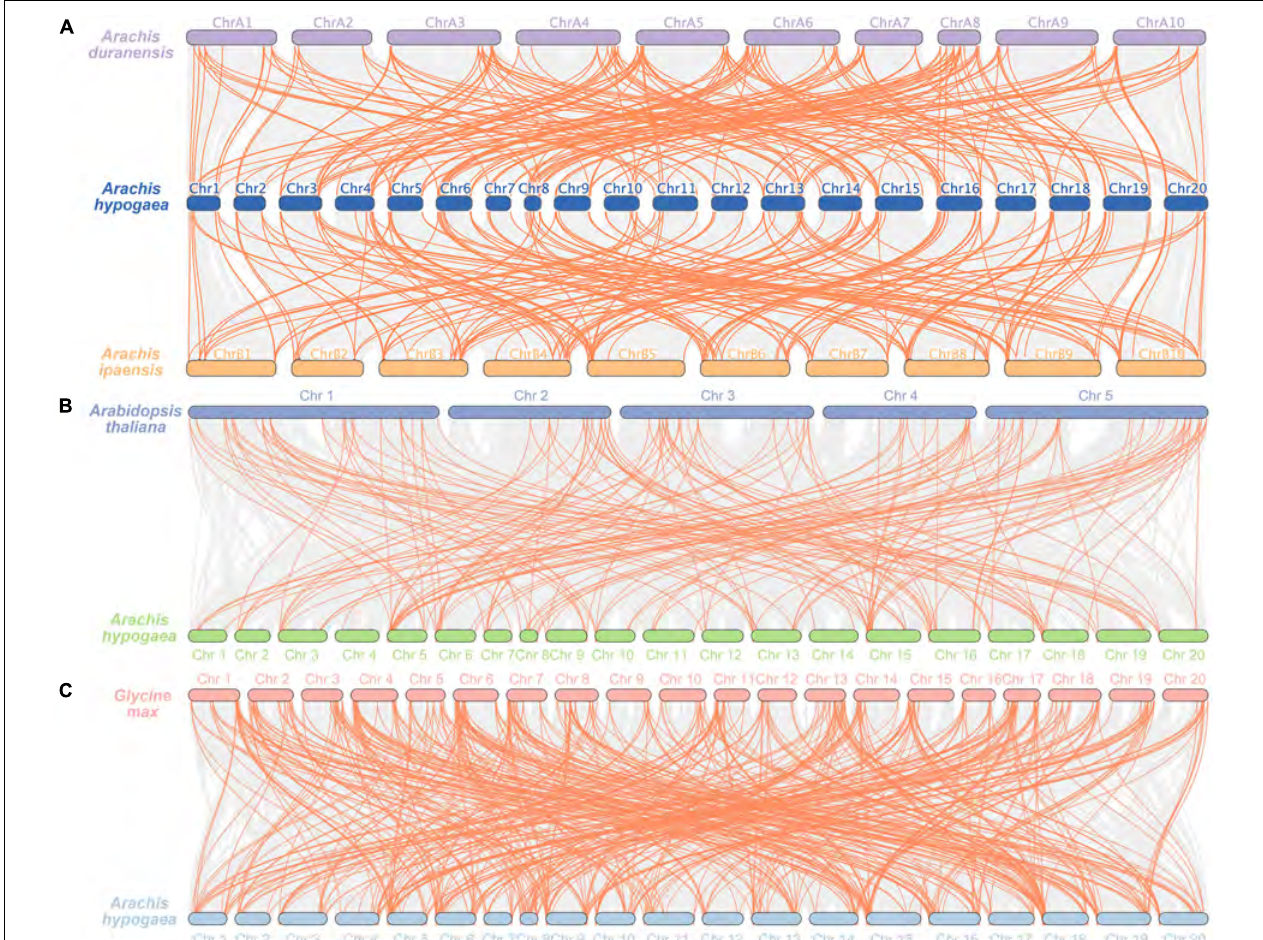
FIGURE 5 | Synteny analysis of AP2/ERF genes between A. hypogaea and four other plant species. Gray lines indicated the syntenic gene pairs within genome, while tangerine lines highlighted the syntenic AP2/ERF gene pairs. (A) Synteny analysis of AP2/ERF genes between A. hypogaea , Arachis duranensis , and Arachis ipaensis ; (B) Synteny analysis of AP2/ERF genes in A. hypogaea vs. Arabidopsis thaliana ( A. thaliana ); (C) Synteny analysis of AP2/ERF genes in A. hypogaea vs. Glycine max